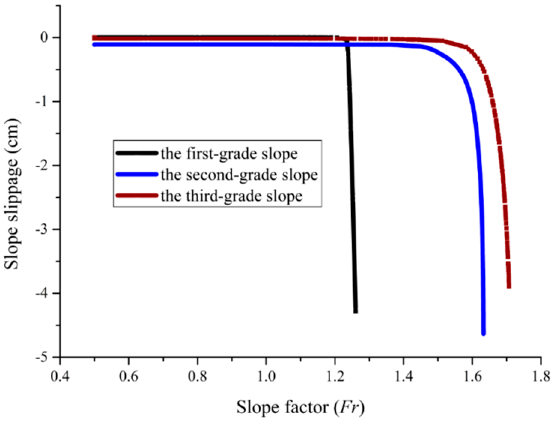
Figure 6. Trend graph of slope safety factor Fr with grading series.